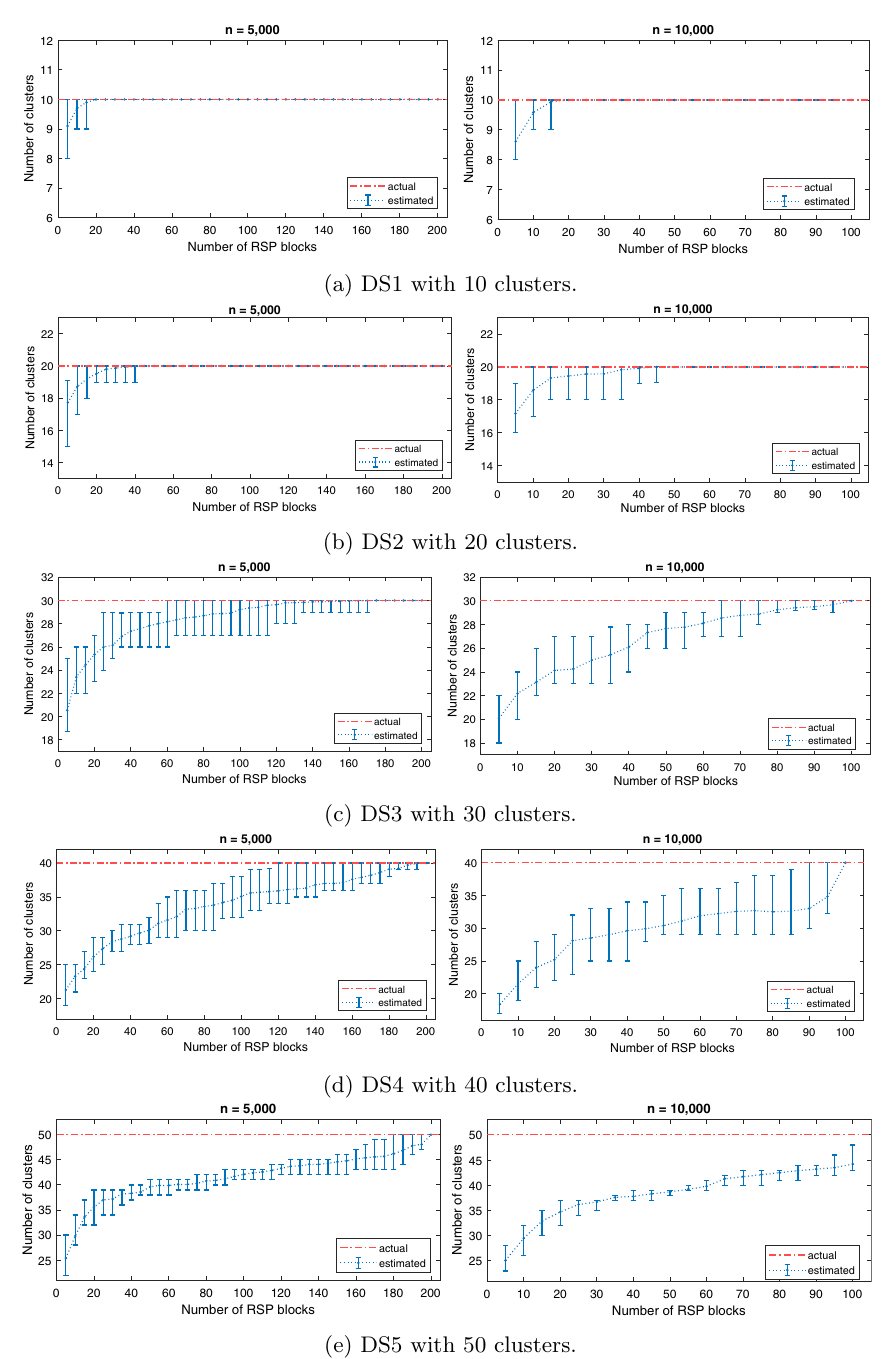
(e) DS5 with 50 clusters. Fig. 5 Performance of the RSPCE algorithm on five synthetic datasets on the maximal, average and minimal numbers of clusters over 20 runs against the number of RSP blocks